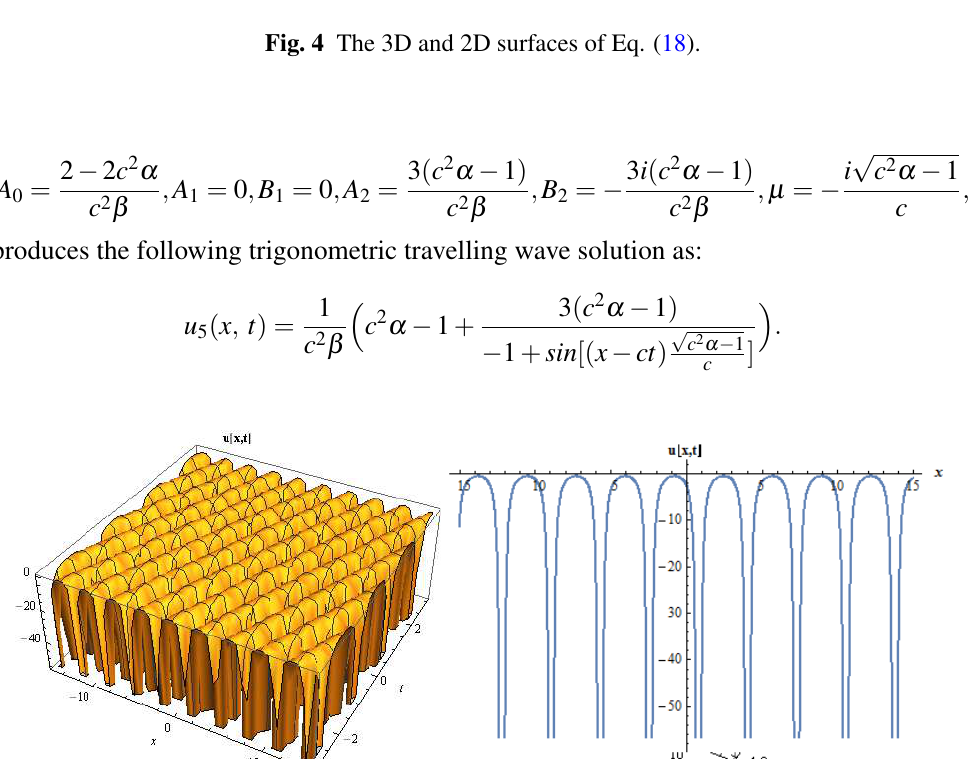
Fig. 5 The 3D and 2D surfaces of Eq.